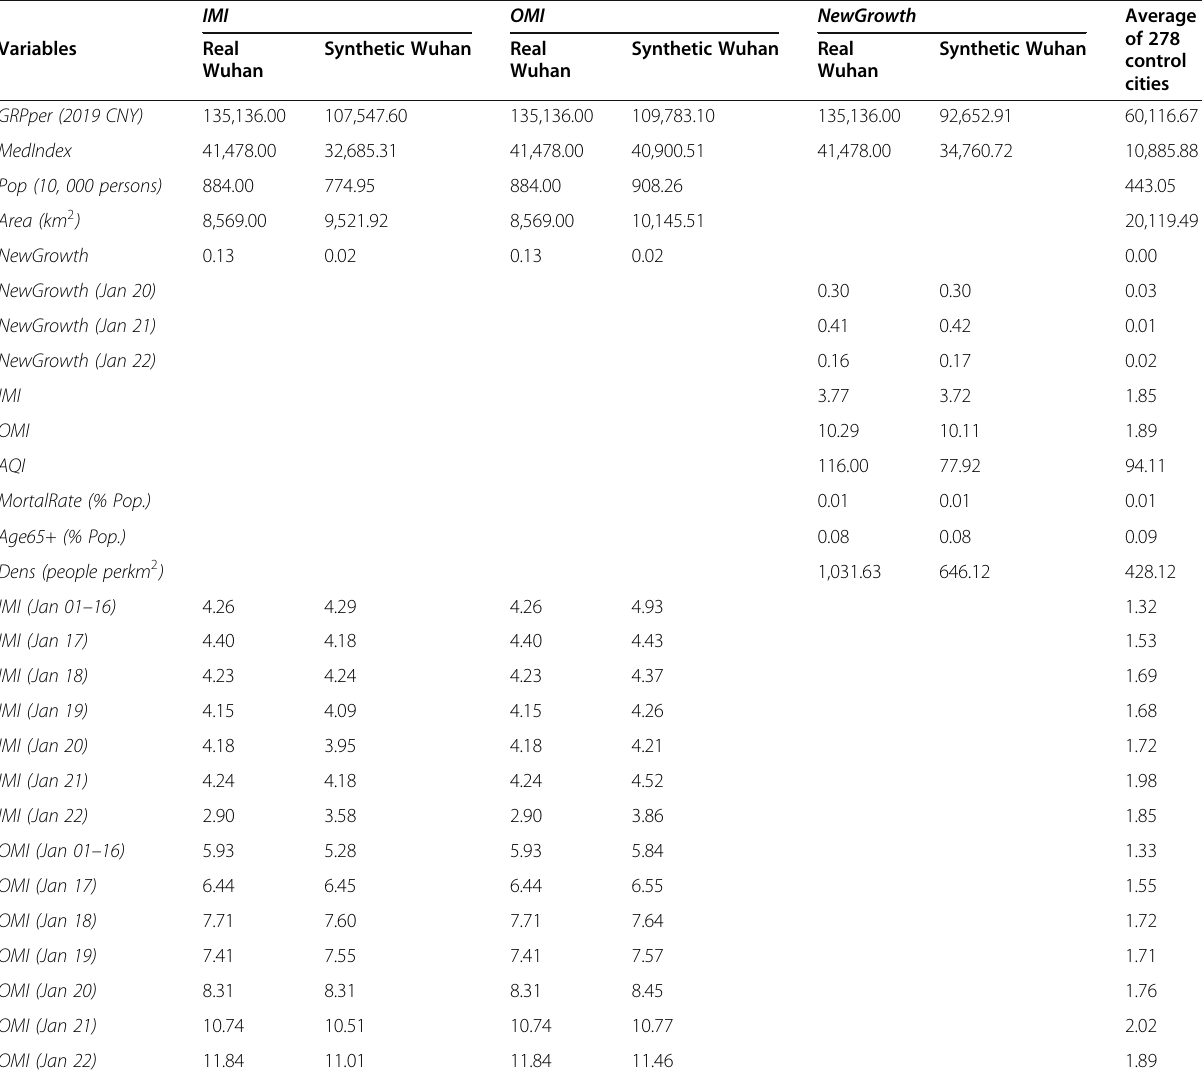
Table 1 Predictor means for IMI , OMI , and NewGrowth IMI OMI NewGrowth Average